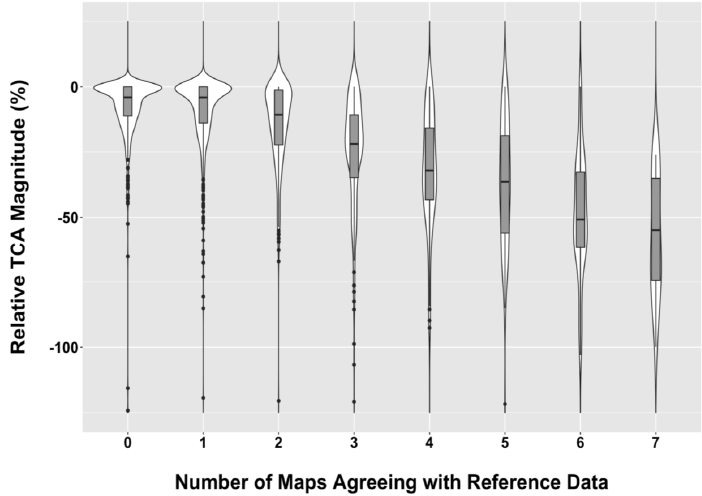
Figure 8. Relative magnitude distributions for disturbance occurrences when no map (0) agreed with reference data, and for occurrences where between one and seven maps agreed.